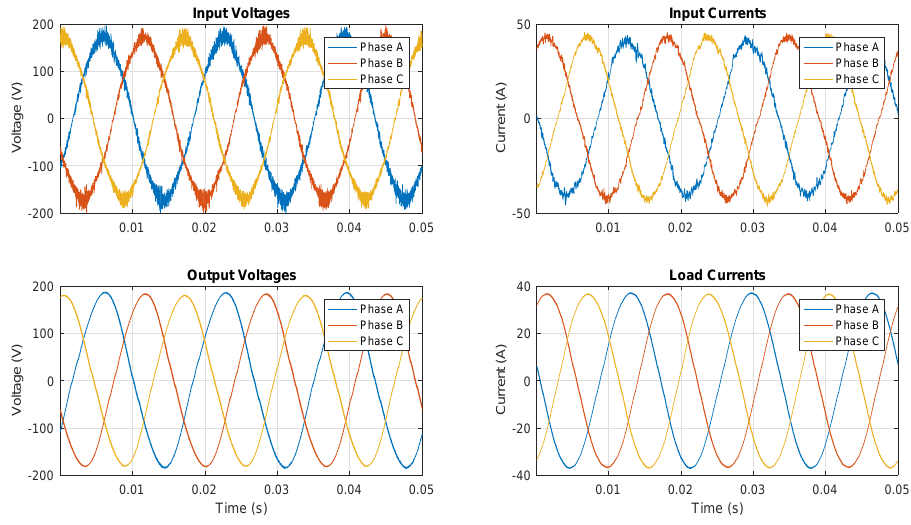
Figure 13. Measured input and output waveforms in steady state at nominal power, the input voltage is 120 V